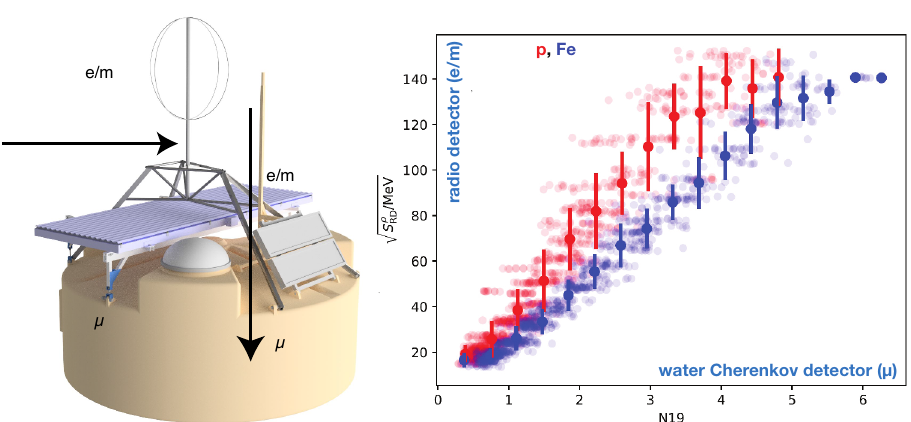
Figure 3. Left: Conceptional illustration of an upgraded station of the Surface Detector array of the Pierre Auger observatory, comprised of (from bottom to top) a water-ˇCerenkov detector, a layer of scintillators, and a radio antenna [32]. The arrows indicate the detection principles for vertical and hor- izontal air showers. In practice, the electromagnetic and muonic components are obtained by unfolding the signals from the Surface Scintillator Detector and the water-ˇCerenkov detector. Right: Electromag- netic energy in a shower as measured by the radio detector as a function of the muon content in a shower as measured by the water-ˇCerenkov detector [32]. P reliminary results from simulations are shown, see main text for more